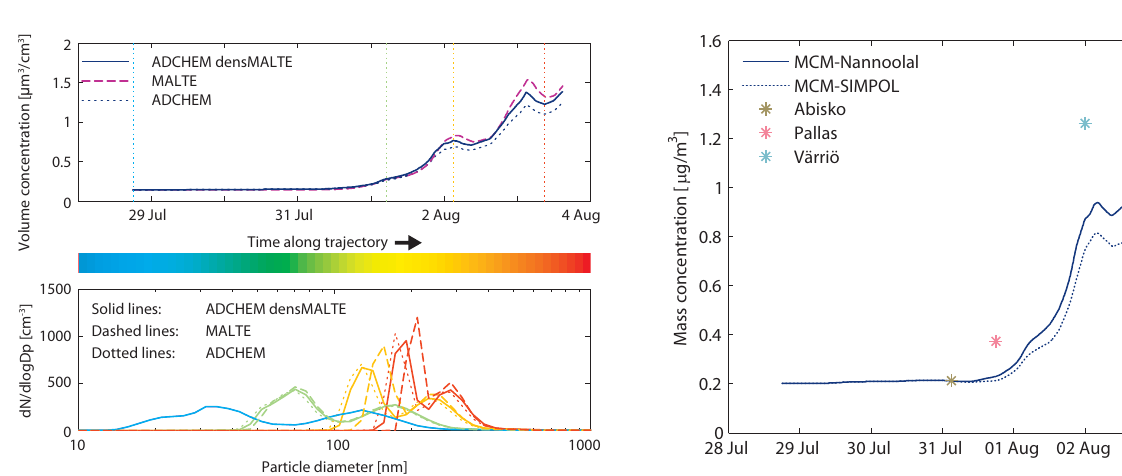
Figure 2. Evolution of particle volume concentration (upper panel) and particle number size distribution (lower panel) modeled with the aerosol dynamics box model MALTE-BOX or ADCHEM (mod- eled with a constant SOA density of 1400kgm − 3 or SOA densities from MALTE-BOX). The color of each size distribution plot rep- resents the size distribution at a specific time along the trajectory, indicated by the corresponding color of the vertical line in the up- per panel.